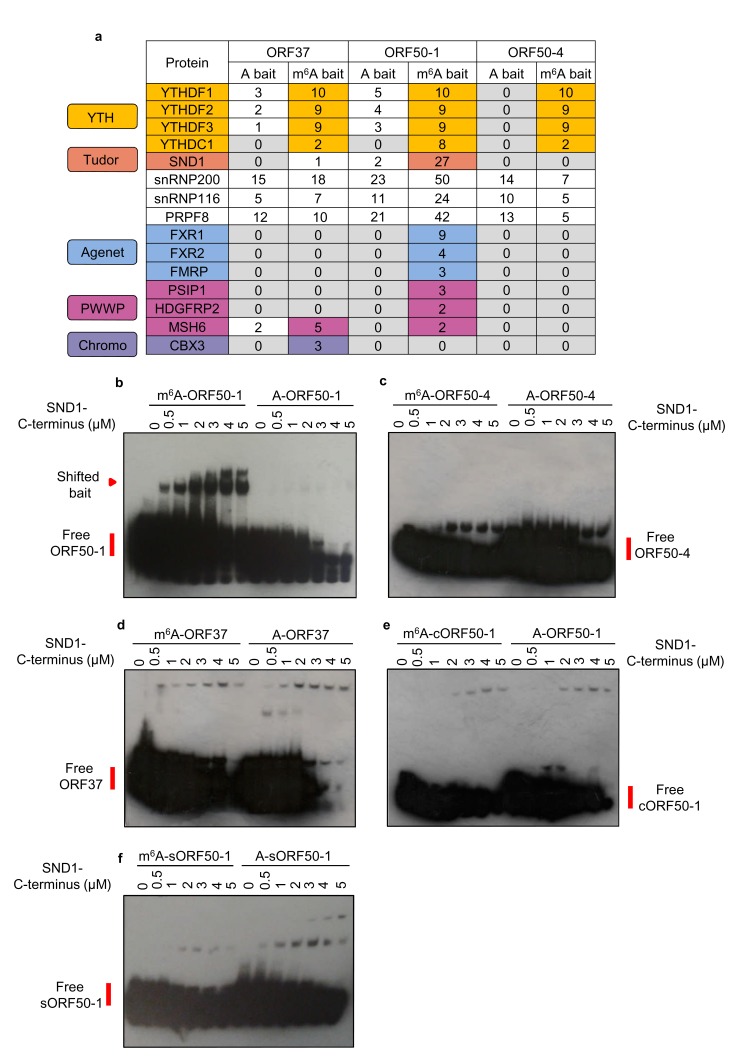
LC-MS/MS identifies members from the ‘Royal family’ as putative m6A readers.(a) Mass spectrometry results of RNA affinity pull-downs using m6A-modified and unmodified (control) biotinylated viral RNA baits. A single RNA affinity biological replicate for each RNA bait was carried out. Statistical significance of enrichment was not determined, instead, all proteins identified for a given methylated and control bait were sorted by total number of peptide spectrum matches (PSM’s) for the m6A bait. Proteins were then considered as enriched in methylated baits if the number of PSM’s assigned to the protein was at least double in the methylated bait compared with the control bait. In this table, the number of unique peptides assigned to each protein is shown for each bait for clarity. (b–f) EMSAs were carried out using recombinant SND1-C-terminus protein (residues 548–910) and biotinylated viral RNA baits. A cropped version of ORF50-1 bait (cORF50-1) and a stable version of ORF50-1 bait (named sORF50-1) in which the beginning of the stem is made to have strong base pairing was also tested. Representative EMSAs from six and two independent protein purifications for b and c-f, respectively.